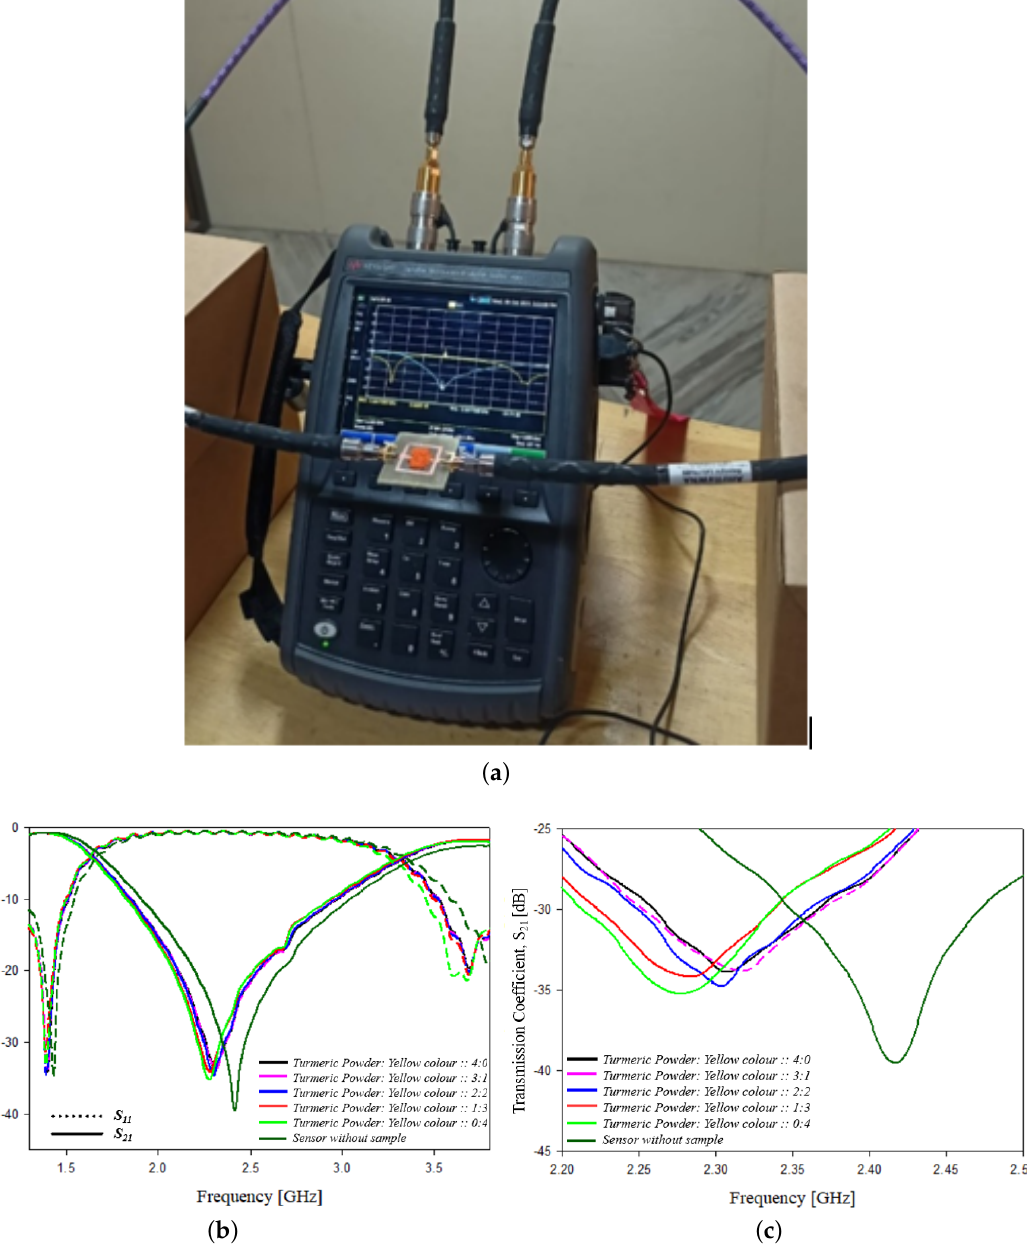
Figure 27. Adulteration sensing in turmeric powder: ( a ) experimental setup, ( b ) variation in scattering parameters with frequency and ( c ) variation in transmission coefficient parameters with